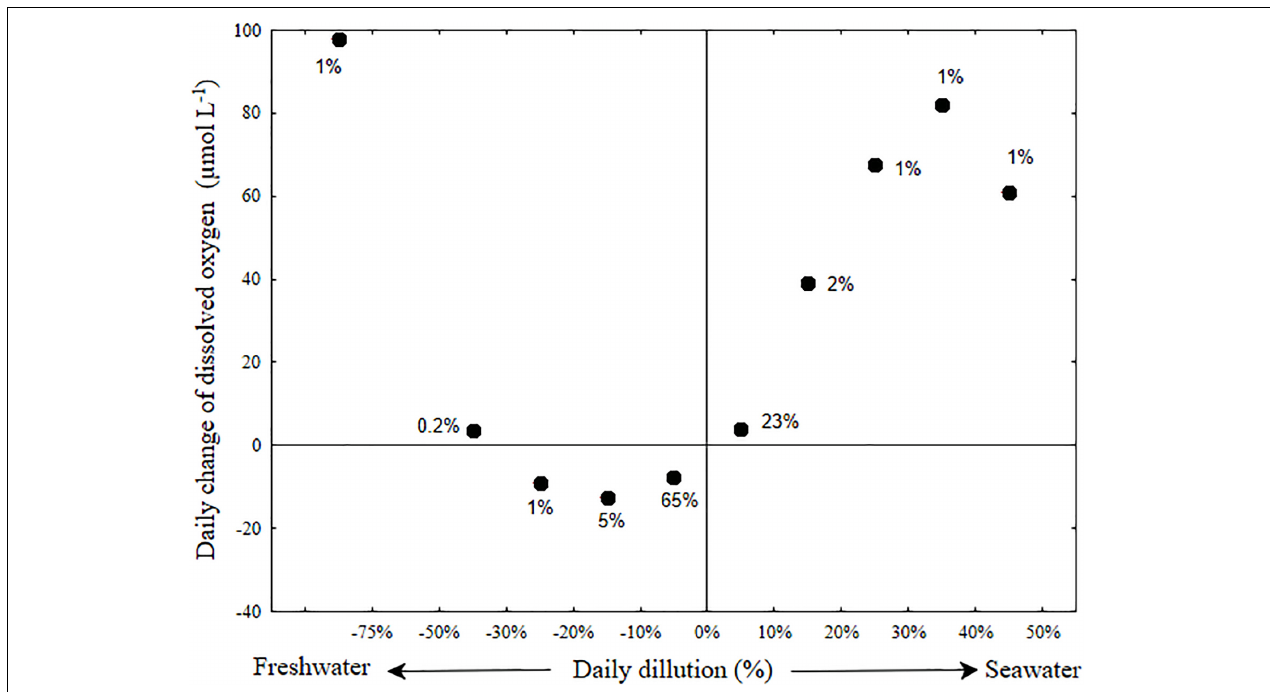
FIGURE 7 | Dilution oxygenation diagram of the Alexander estuary bottom water. The day to day oxygenation rate ( Y -axis) averaged for each bin of daily dilution rate ( X -axis). Error bars were removed for clarity (see Supplementary Figure S6 ). The term daily dilution refers to the percent of water replaced by seawater or freshwater calculated from the salinity change. Positive values refers to dilution with seawater and negative values to dilution with fresh water. Day to day oxygen change, refers to the difference between the median of oxygen concentration measured on consecutive day. The labels near the datum indicates the percentage of days (out of a total of 559 days) in each